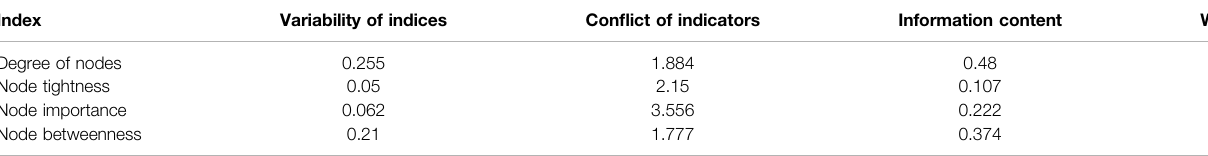
TABLE 5 | CRITIC weighting calculation results.